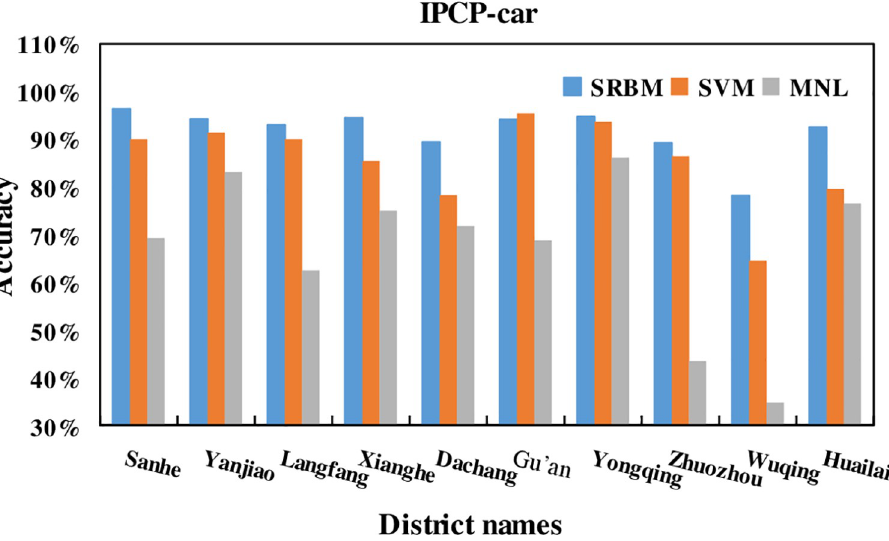
Fig 12. Car accuracy of SRBM, SVM and MNL model.